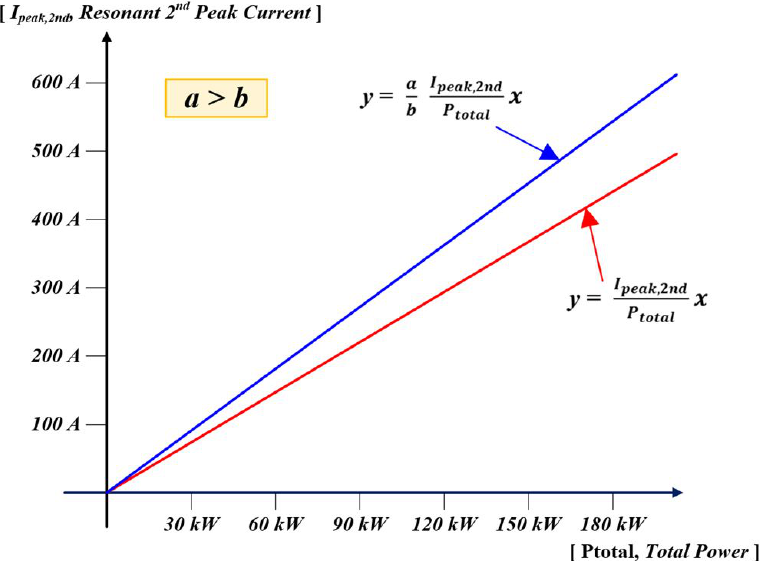
Figure 16. Transformer secondary current peak value corresponding to the load capacity.